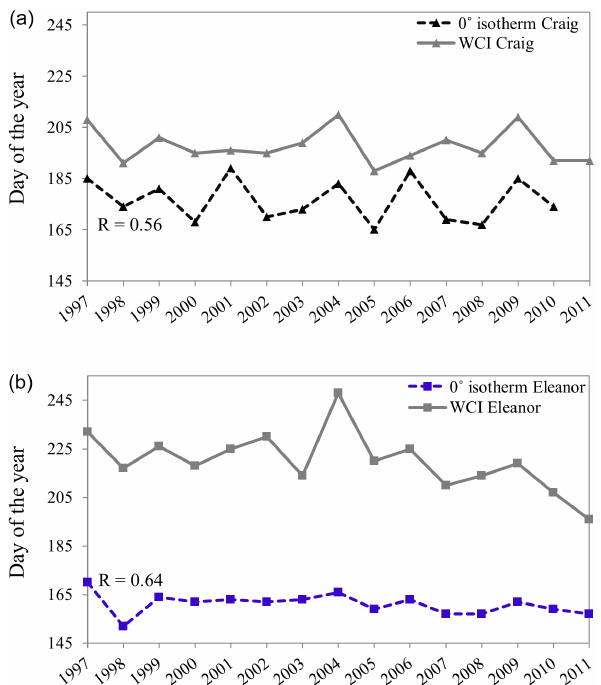
Figure 8. Water-clear-of-ice dates relative to the 0 ◦ C spring isotherm date between 1997 and 2011 for (a) Craig Lake (polar oasis) and (b) Eleanor Lake (polar desert). Spearman’s rank corre- lation coefficient ( R ) is also